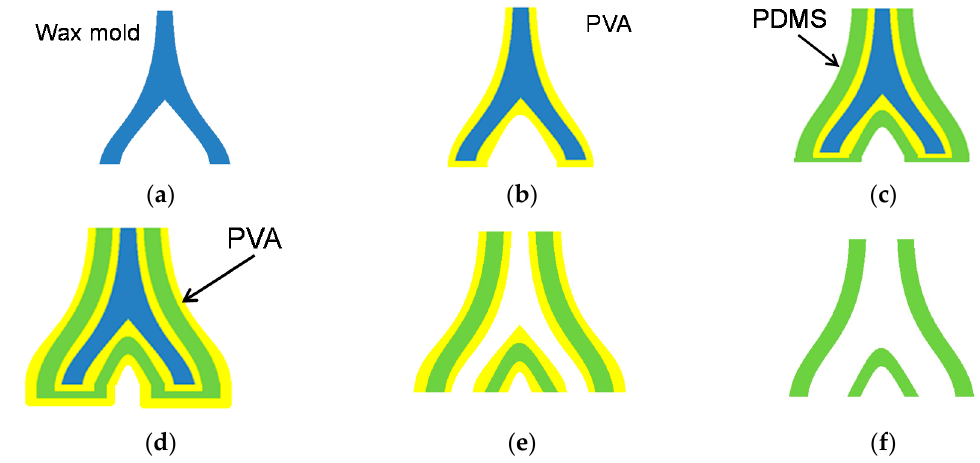
Figure 3. Fabrication process of 3D vessel model with temperature-indicating function. ( a ) Wax mold; ( b ) Dip-coating of PVA; ( c ) Dip-coating of PDMS with temperature-indicating function; ( d ) Dip-coating of PVA; ( e ) Removal of wax mold; ( f ) Removal of PVA.